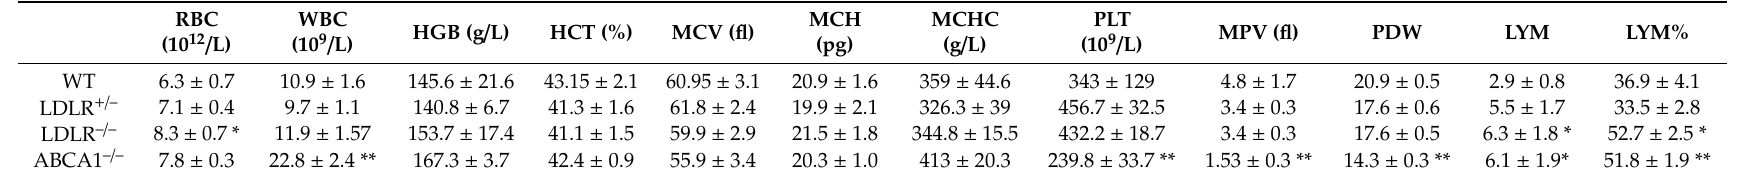
Table 1. Overview of the hematologic parameters in WT, LDLR +/ – , LDLR – / – , and ABCA1 – / – hamsters before IS